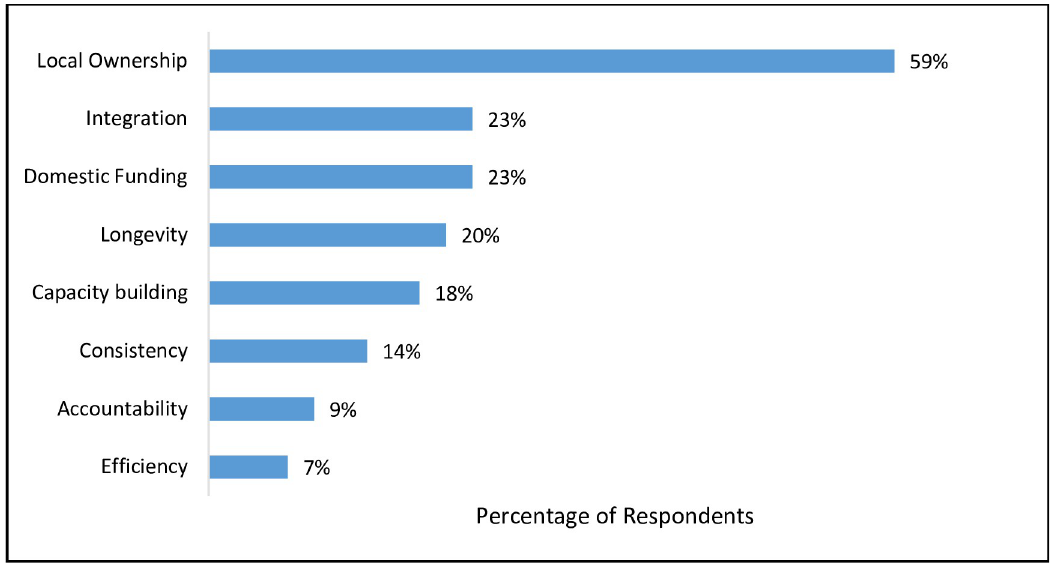
Fig 2. Themes of Words and Phrases Mentioned for Characterizing